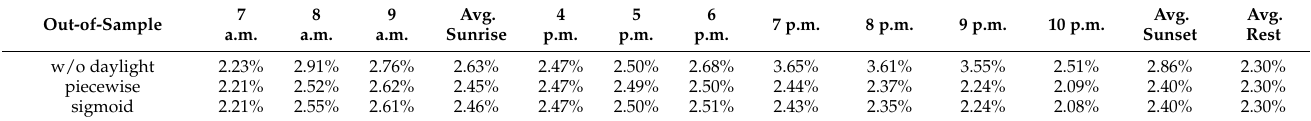
Table 3. Modeling error for each time of day for out-of-sample